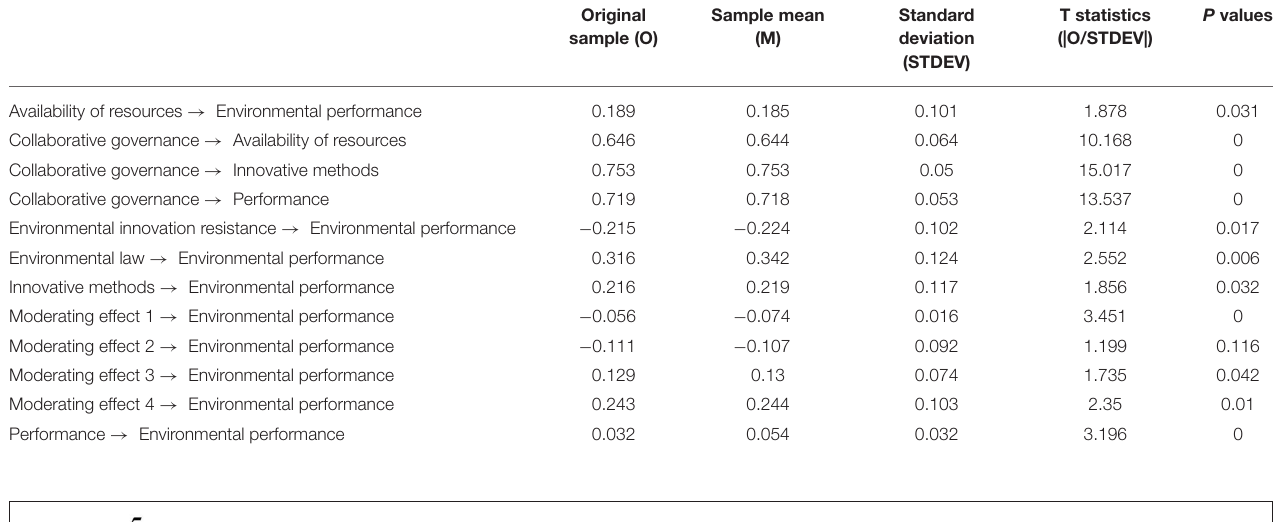
TABLE 4 | Direct effect results.